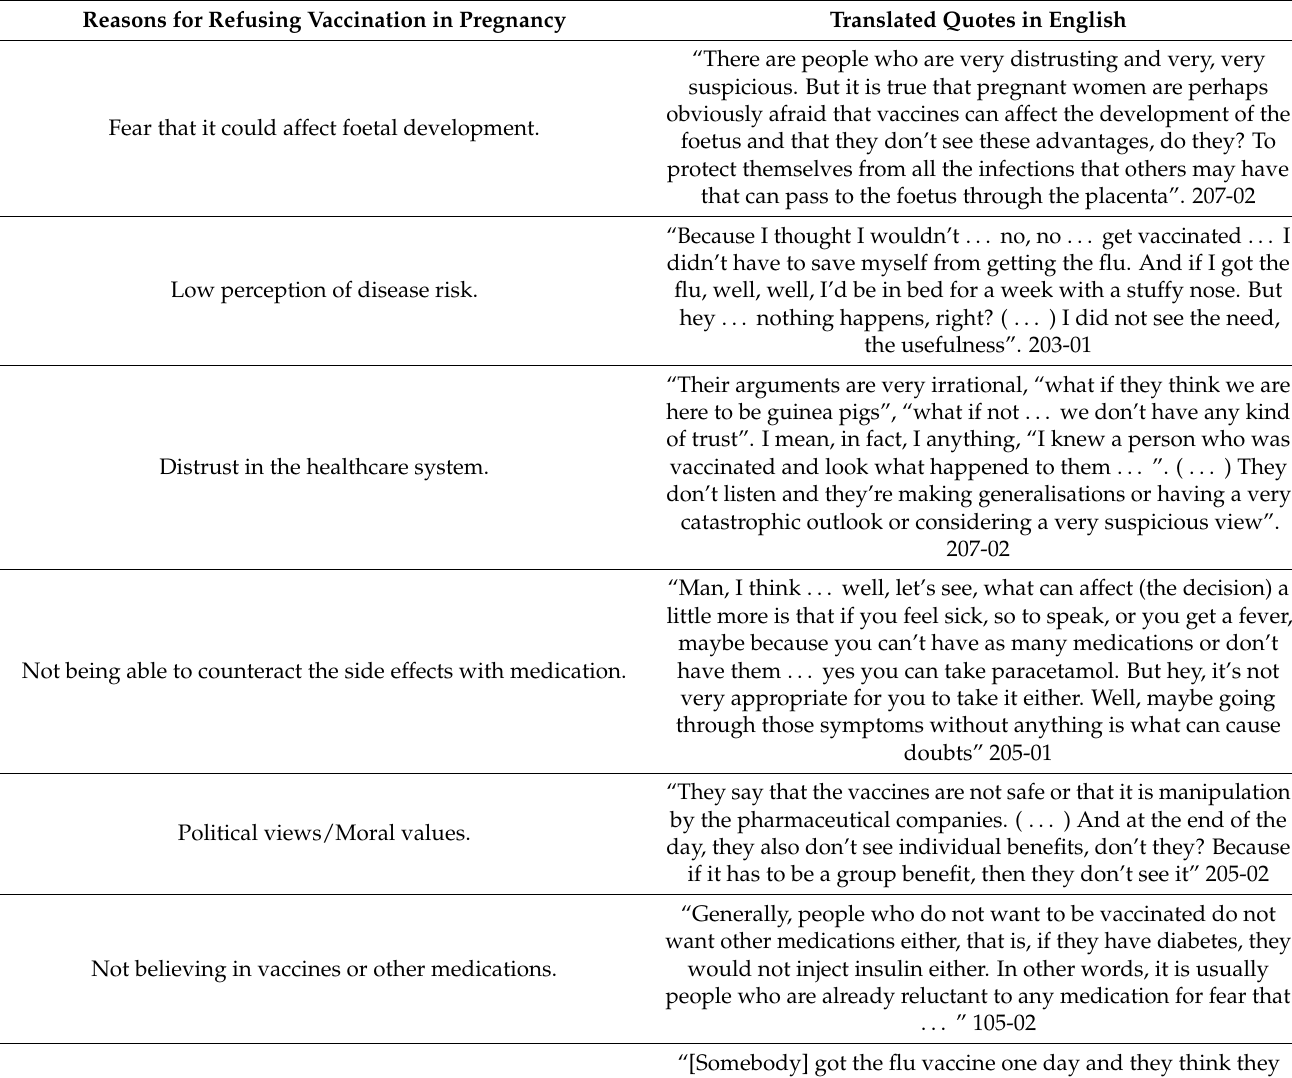
Table 3. Motivational factors for deciding not to be vaccinated during